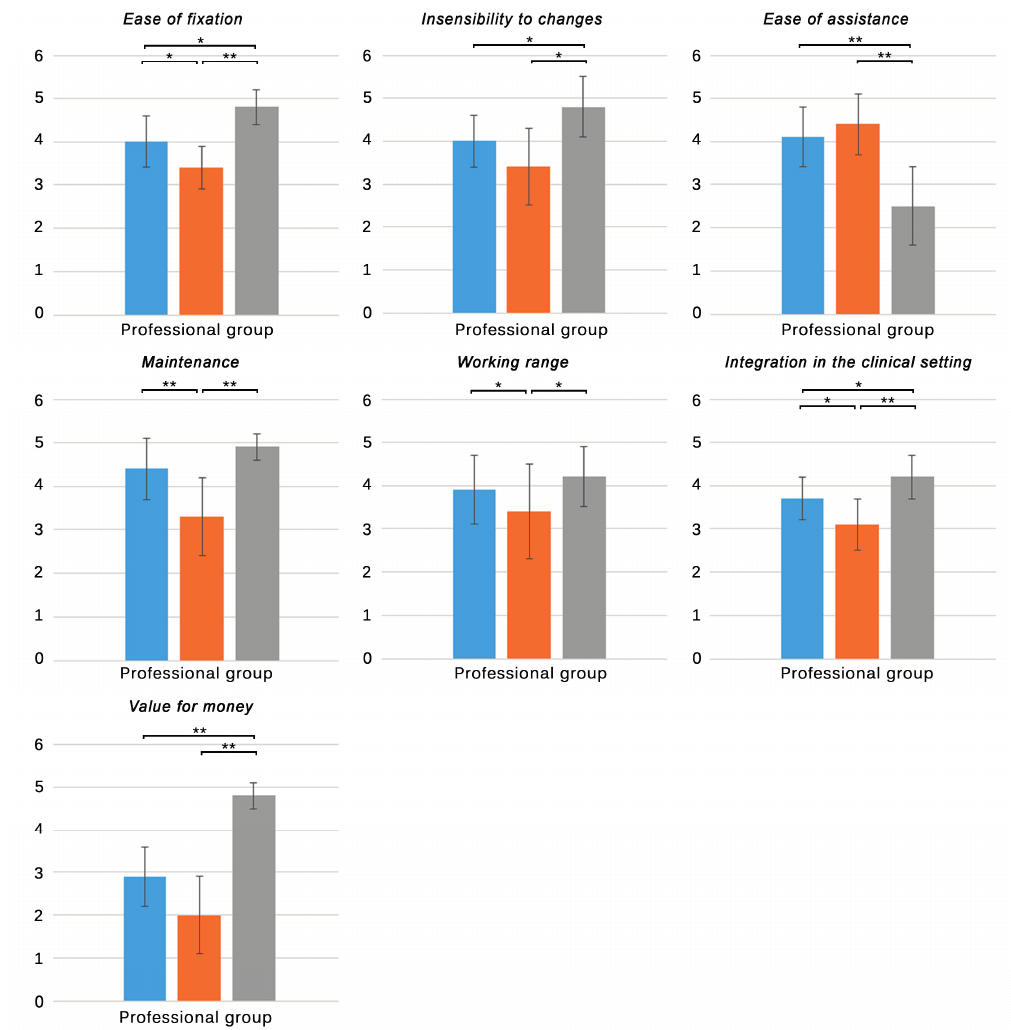
Figure 6. Subjective responses of therapists to items five to nine of questionnaire B. Blue : NaturalPoint ® OptiTrack TM ; Orange : Polhemus TM G4 TM ; Grey : Microsoft ® Kinect TM . Only significant differences are stated. * p < 0.05, ** p < 0.001.